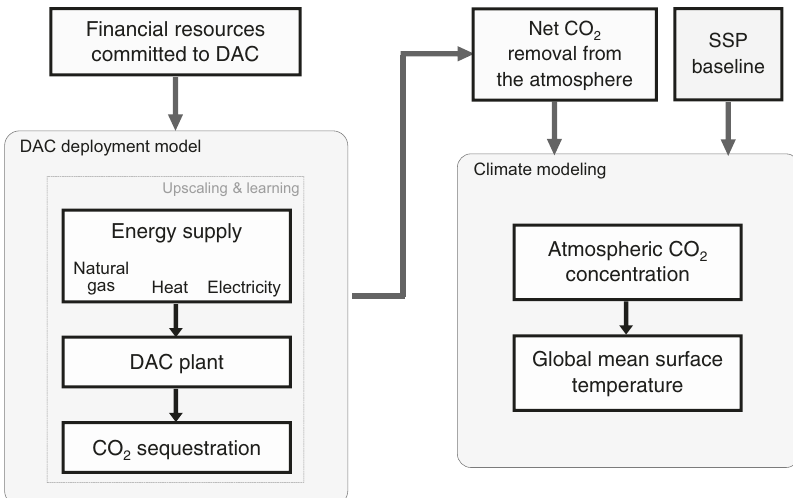
Fig. 1 Conceptual schematic of the modelling framework. The model calculates impacts on the climate system due to DAC deployment and comprises three main parts: (1) an estimate of the fi nancial resources available to fund DAC; (2) deployment of a fl eet of DAC plants, including requisite supplies of electricity and heat, and upscaling of these DAC-energy system combinations over time; and (3) the impact of these DAC-energy systems on atmospheric CO 2 concentration and global mean surface temperature, given background emissions which are taken from the shared socioeconomic pathways (SSP). (See Supplementary Fig. 1 for a more detailed